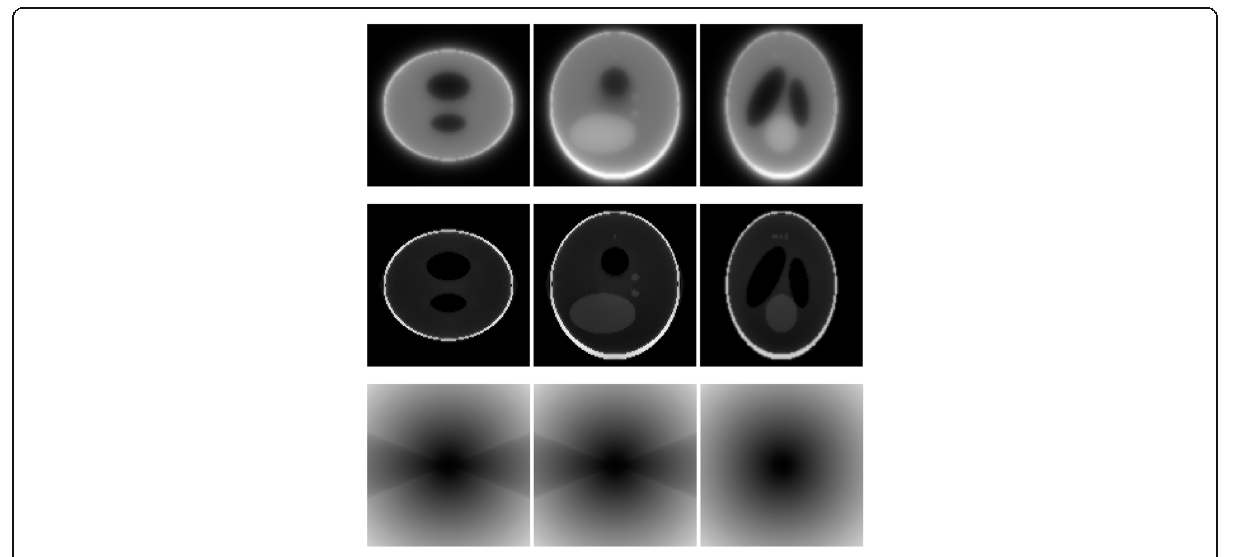
Fig. 10 Image reconstruction using proposed algorithm for the case of ψ = 3 π /8 and σ = 10. Row 1 : TOF backprojection. Row 2 : Final reconstruction. Row 3 : Tomographic filter H . Three central orthogonal cuts are shown for each row